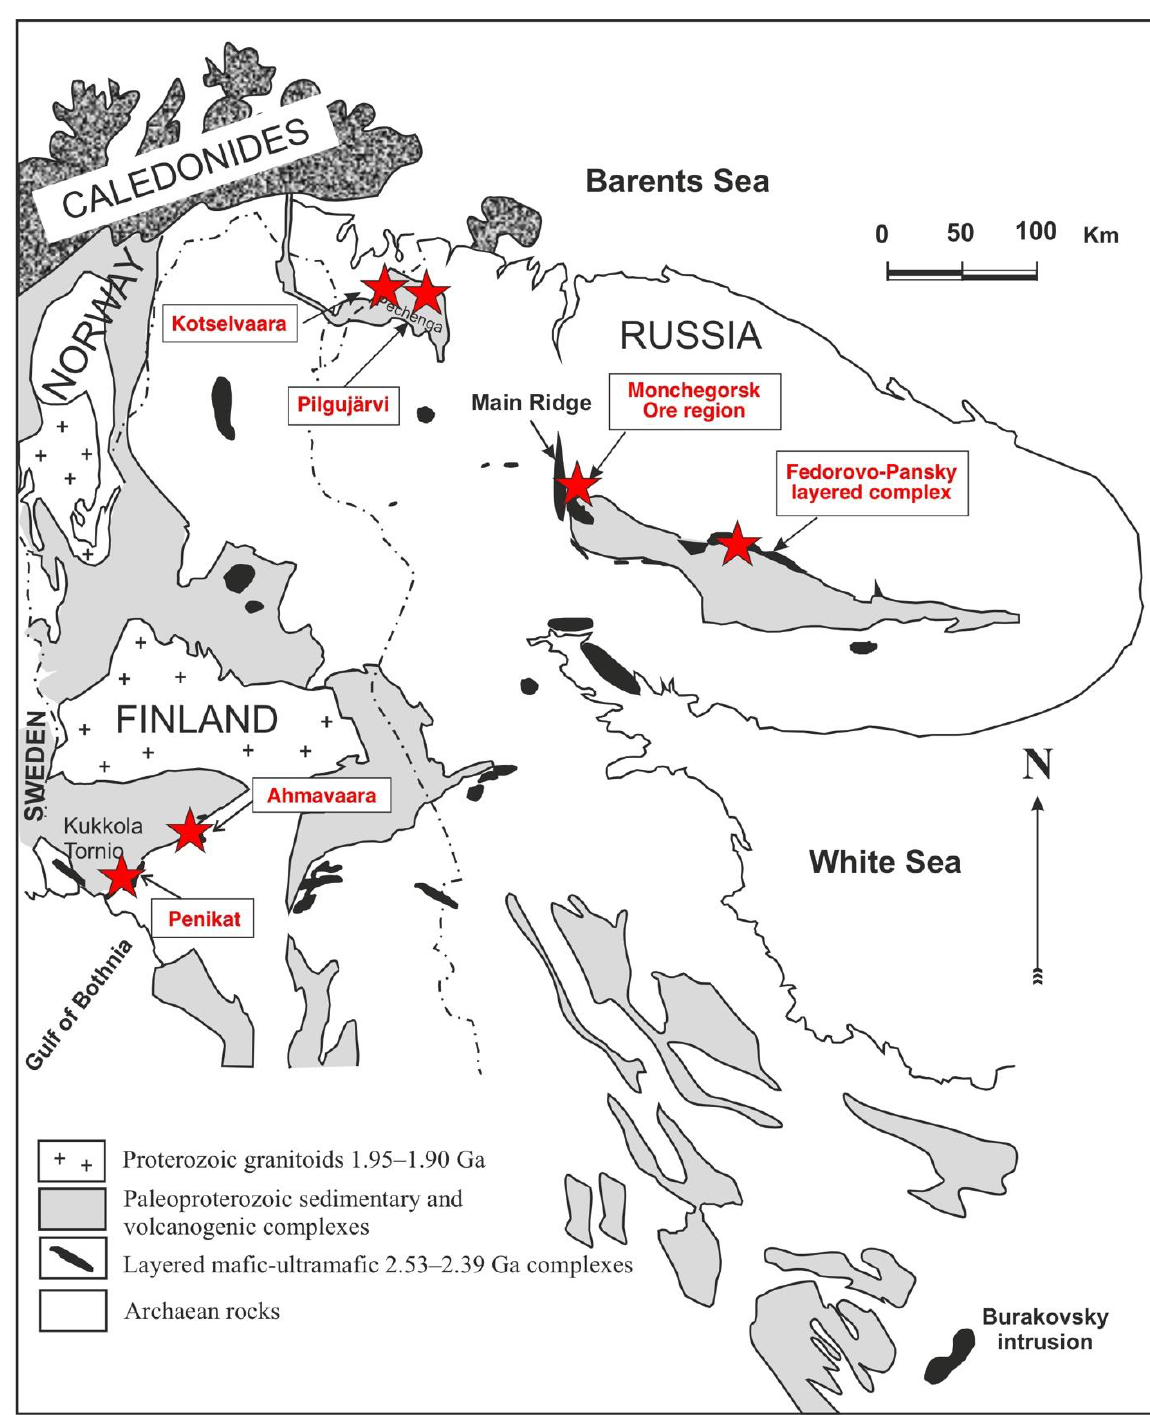
Figure 1. Generalized geological map of the northeastern part of the Fennoscandian Shield and the location of main Paleoproterozoic mafic–ultramafic Cu-Ni complexes (modified from [1]. Red asterisks indicate sampling locations).